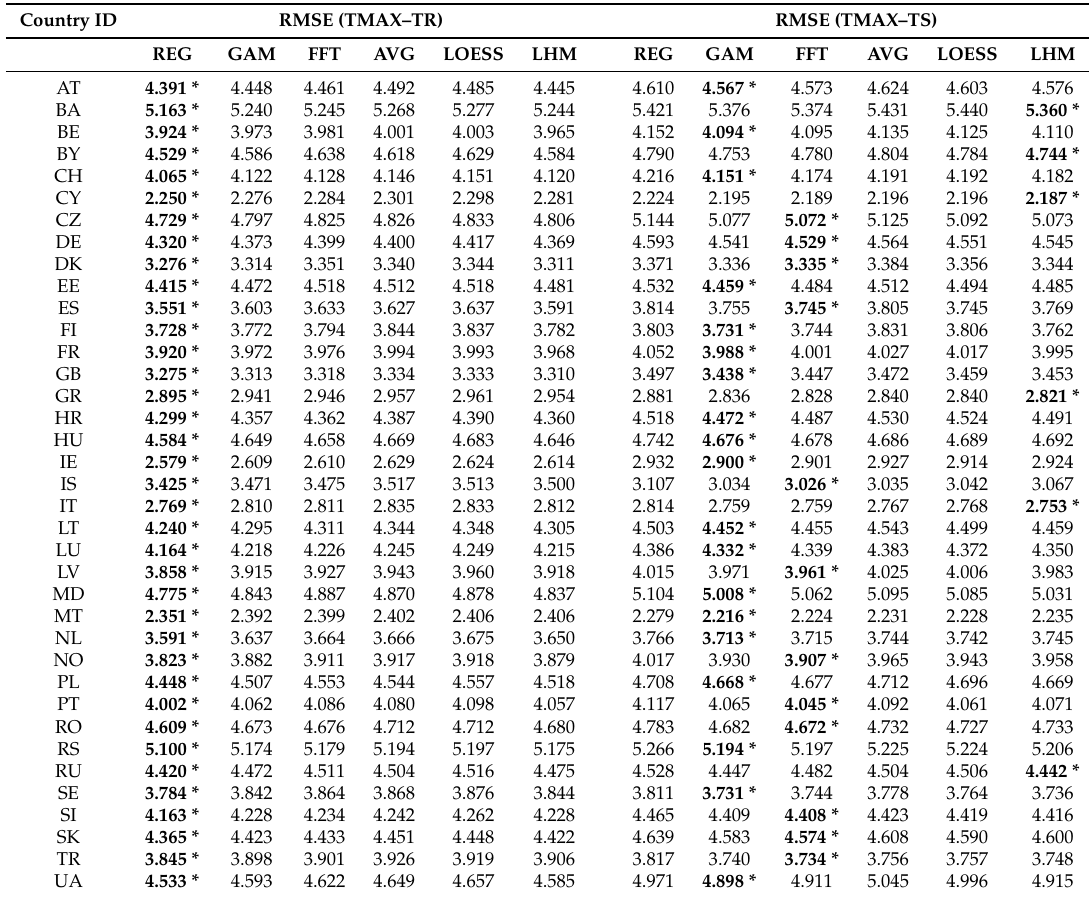
Table 6. Summary of the in-sample (TR) and out-of-sample (TS) errors for the maximum temperatures, obtained with all the different methods and for all the countries. The bold values with * indicate the best method for each country and